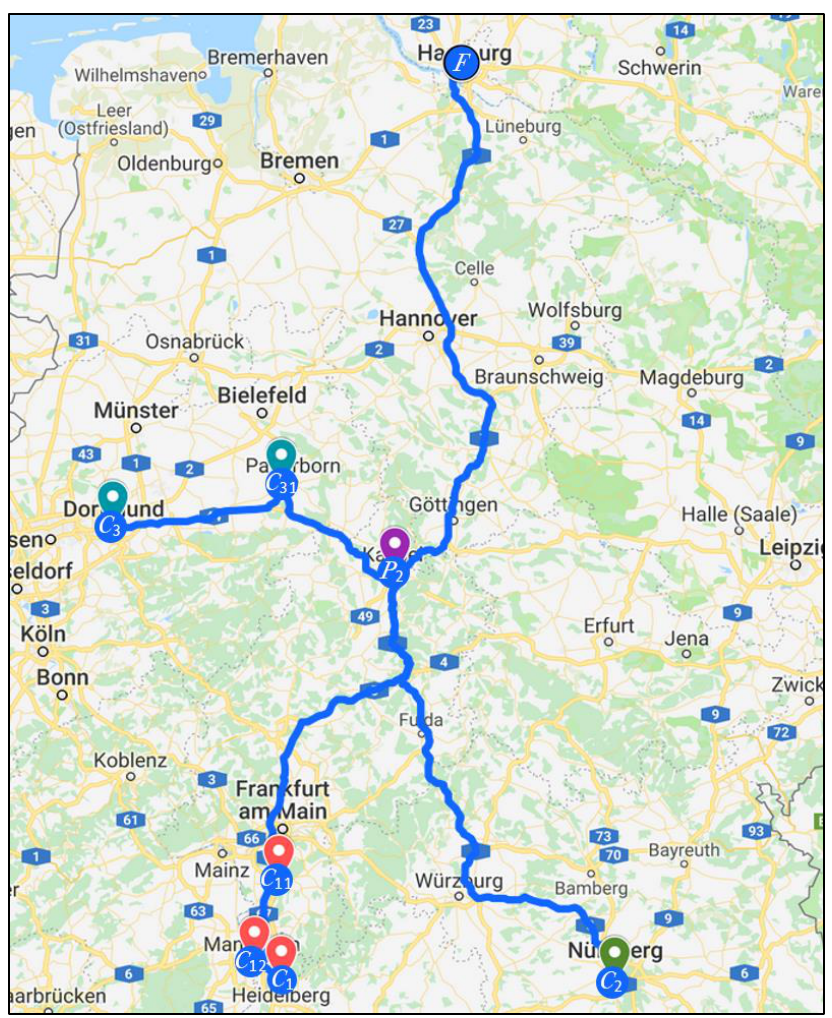
Figure 7. Proposed situation with a mobile hub in Kassel (indicated in purple).